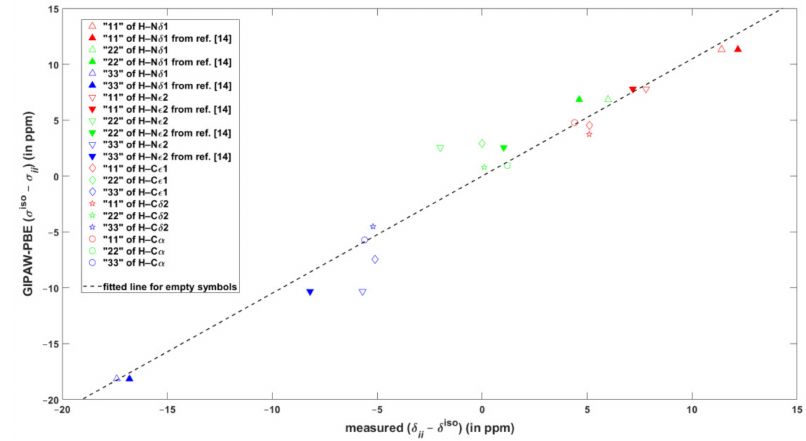
Figure 2. The correlation of the calculated and experimental di ff erences between the values of the isotropic chemical shift / shielding and of the respective principal element of the 1 H chemical shift / shielding tensors in L-histidine hydrochloride